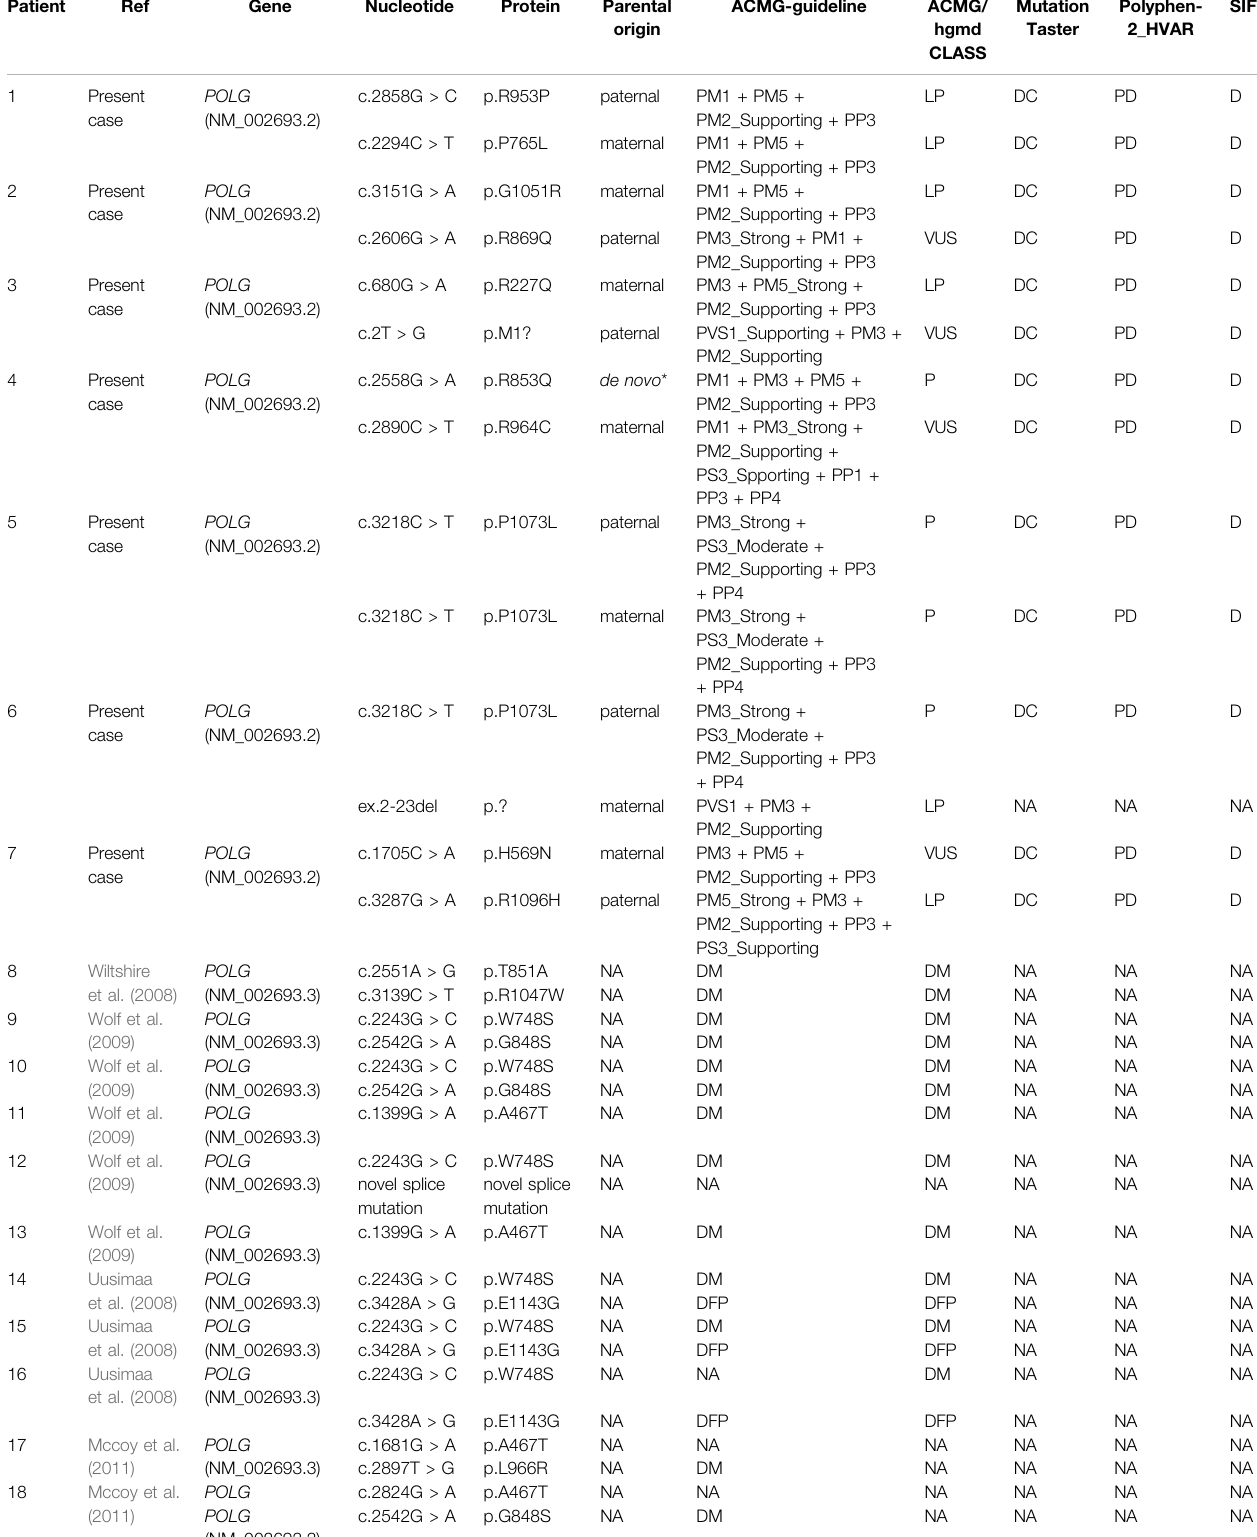
TABLE 1 | Summary of the Genetic mutation variants of 29 cases with Alpers ’